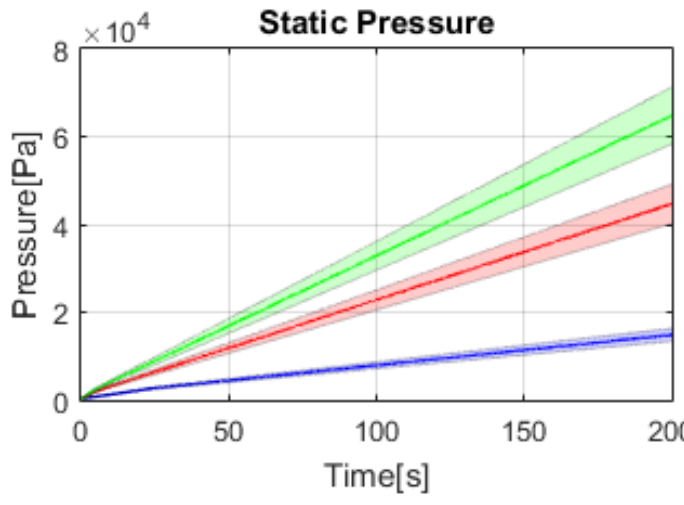
Figure 10. Comparison of the three pressure diagrams, 8 L/min (blue diagram), at 27 L/min (red diagram) and 40 L/min (red diagram).